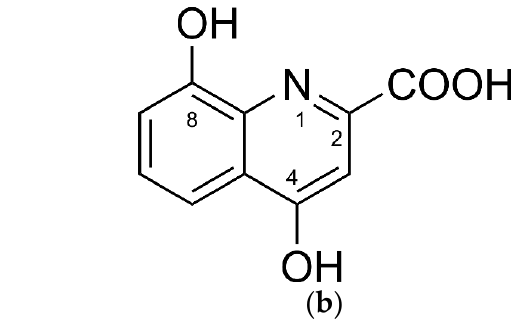
Figure 1. Chemical structures of ( a ) kynurenic acid and ( b ) xanthurenic acid.